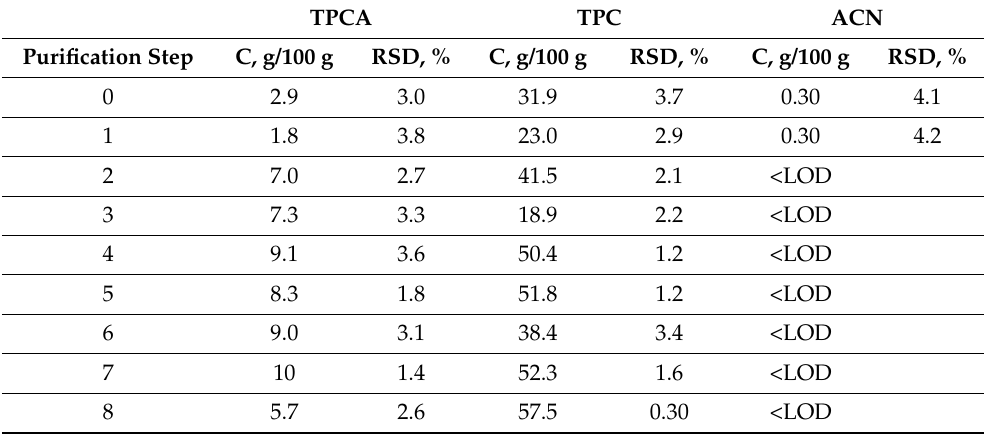
Figure 3. The purification of the prepared optimal procyanidin extract from cranberry press residues. Solvents indicated on the arrows are the solvents used for the elution of the specific fraction. The number indicated in green boxes are the fraction (purification steps) numbers represented in Table 3 with representative quantitative data. Table 3. Quantitative analysis of group parameters in the purified fractions of cranberry press residue procyanidin extract. “Purification Step” represents the number of sample fractions during the purification process as indicated in Figure 3. RSD—relative standard deviation, n =